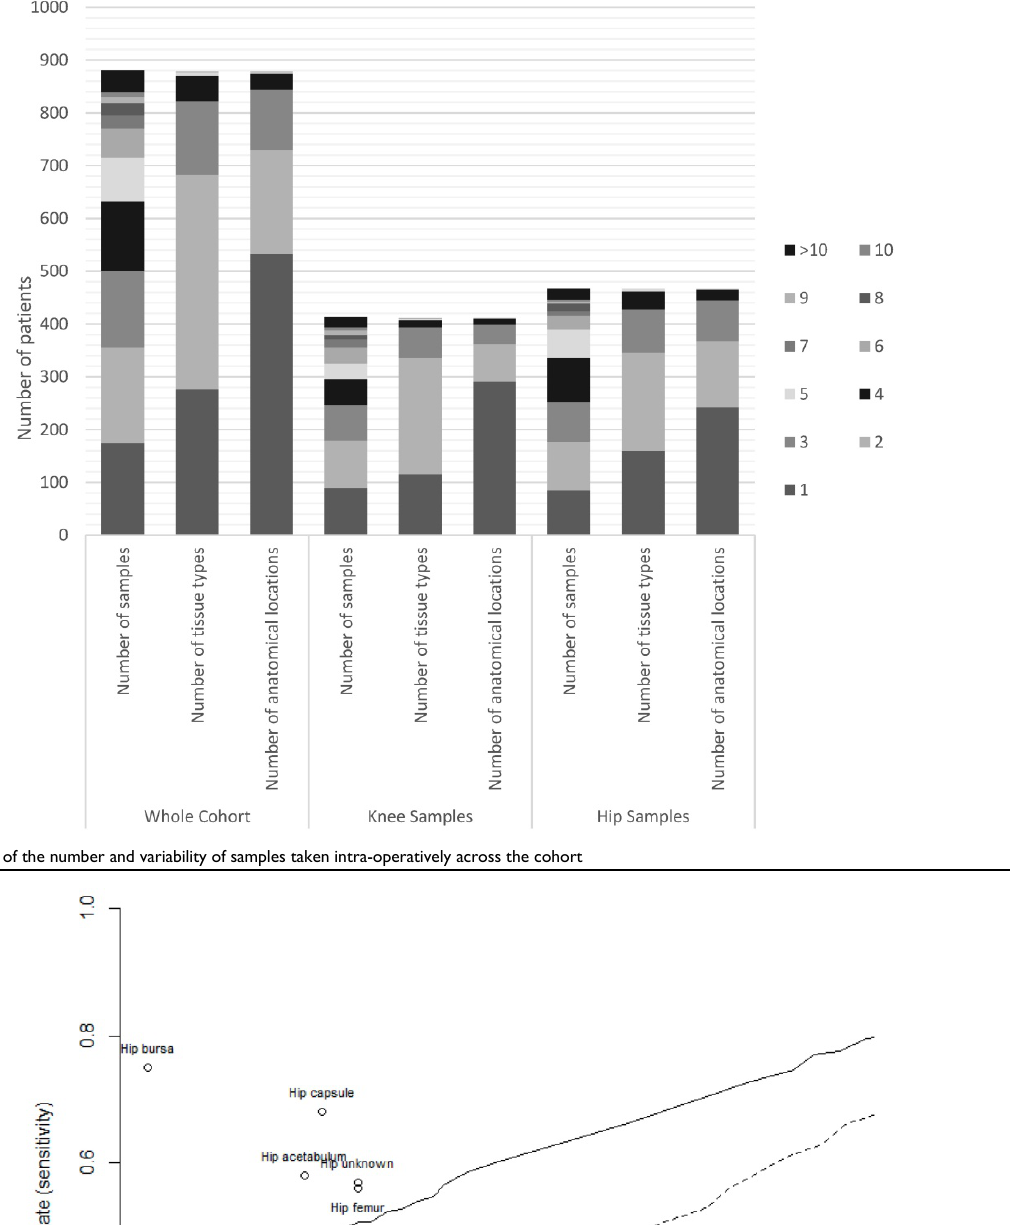
Figure 3: Distribution of the number and variability of samples taken intra-operatively across the cohort